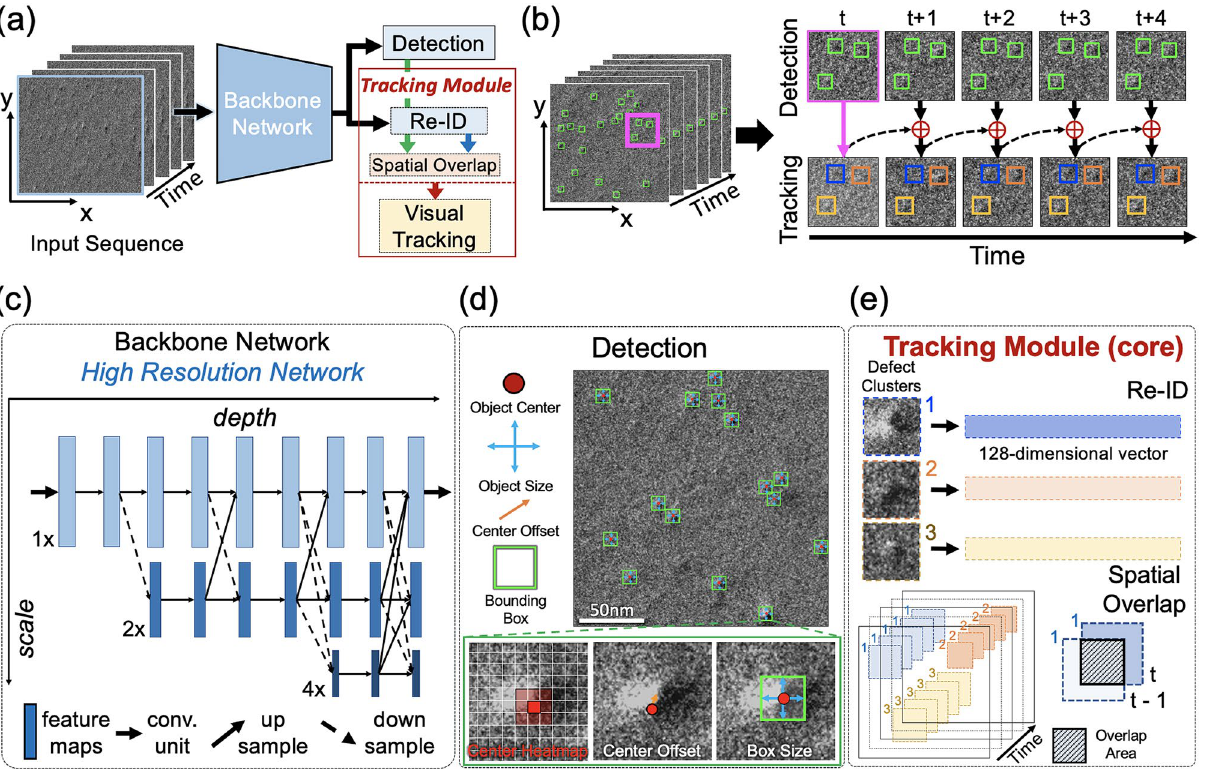
Figure 3. Overview of our DefectTrack model network. ( a ) DefectTrack architecture. ( b ) Schematics of how DefectTrack achieves tracking via detection and tracklets association. ( c ) The neural network architecture of